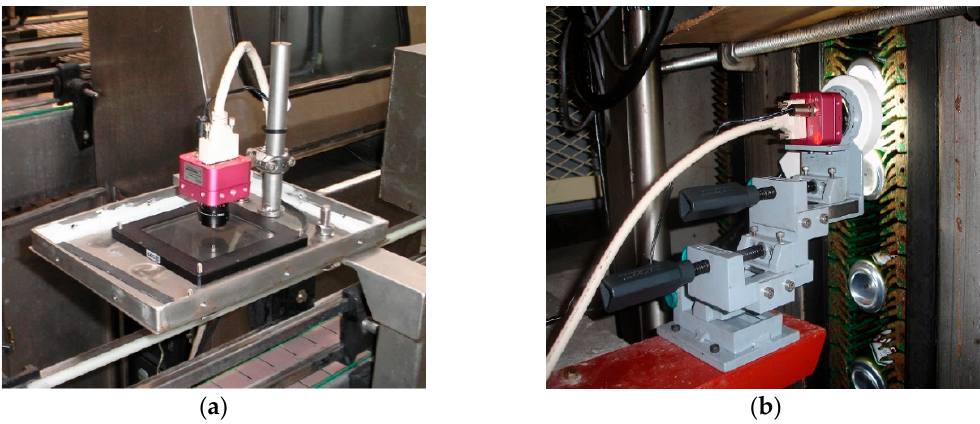
Figure 1. Image acquisition devices on a conveyor belt with a capacity for 200 captures per second (black and white) in a ( a ) horizontal plane and ( b ) vertical plane.